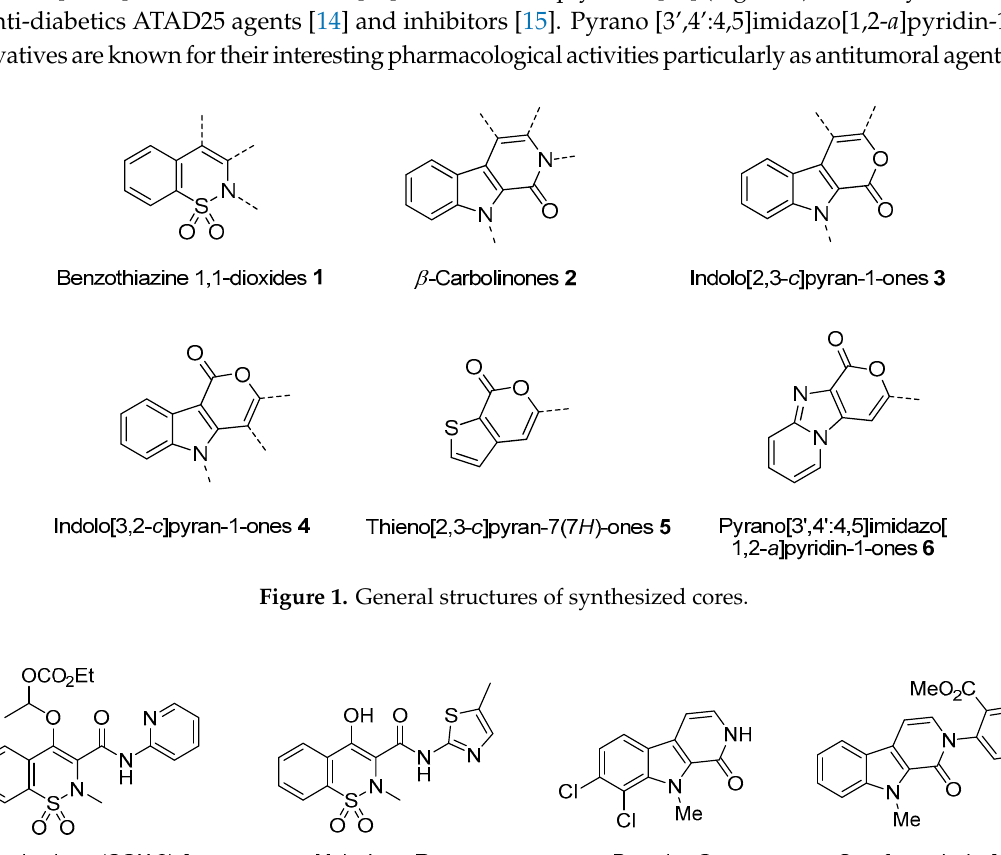
Figure 2. Biologically active benzothiazine dioxides and β -carbolin-1-ones.